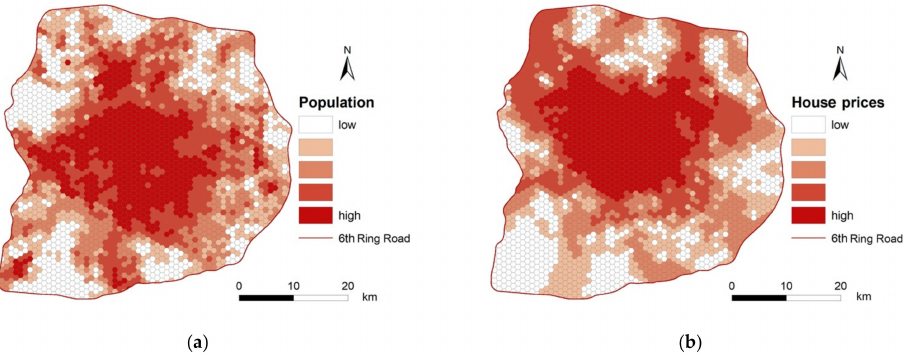
Figure 5. The spatial distribution of ( a ) population and ( b ) the house price of each spatial